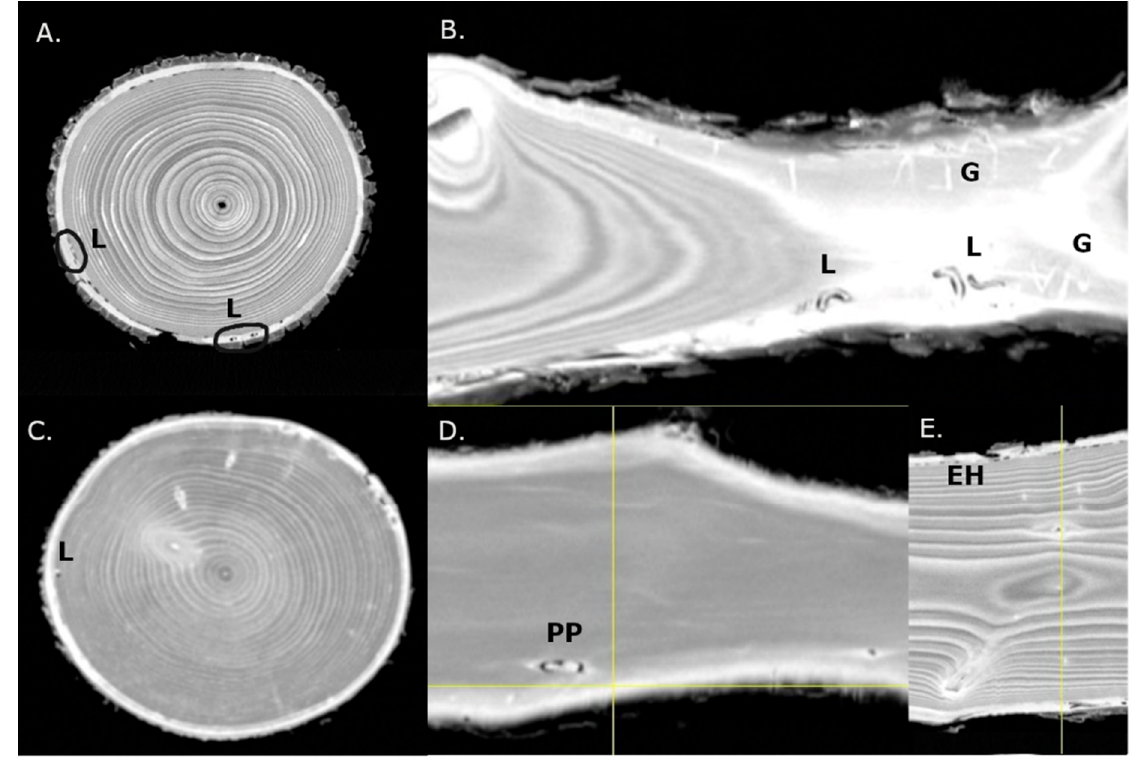
Figure 1. Images obtained from CT-scan showing the developing larvae (L) and prepupae (PP), larval galleries (G), and emergence holes (EH) in ( A ) a transversal section and ( B ) a longitudinal section of an ash sample and in ( C ) a transversal section and ( D , E ) longitudinal sections of a white birch sample.